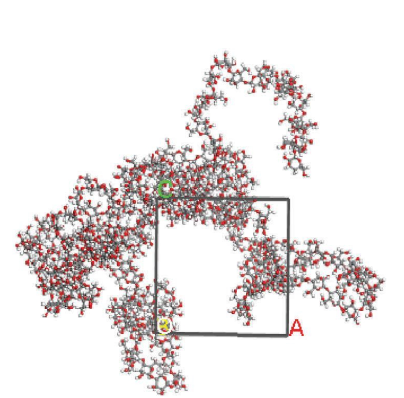
Figure 3: Model of cellulose amorphous system.